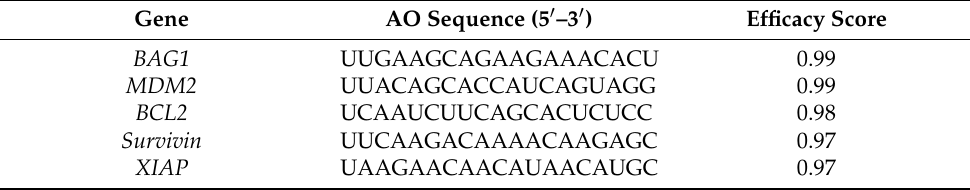
Figure 8. AuNPs-based BCR-ABL gene silencing. (1) AuNPs functionalized with the e14a2 antisense hairpin ssDNA oligonucleotide (AuNP-PEG-e14a2) internalized by K562 cells, a CML in vitro model. (2) The nanoconjugate recognized BCR-ABL1 mRNA and induced silenced-gene expression and trig- gered mRNA degradation, thereby inhibiting (3) tyrosine kinase. The nanoconjugate (4) upregulated Bax and caspase-3, while it downregulated BCL2 expression. (5) AuNP-PEG-e14a2 increased apopto- sis, resulting in decreased cell proliferation and survival. (6) IM combined with AuNP-PEG–e14a2 could be used to overcome chemoresistance. The idea of this figure was reprinted from Vinhas et al. (2017) [113]. Gold nanoparticles: AuNPs; Imatinib: IM. Table 2. The best AO sequence for BAG1, MDM2, Bcl-2, BIRC5 (survivin), and XIAP